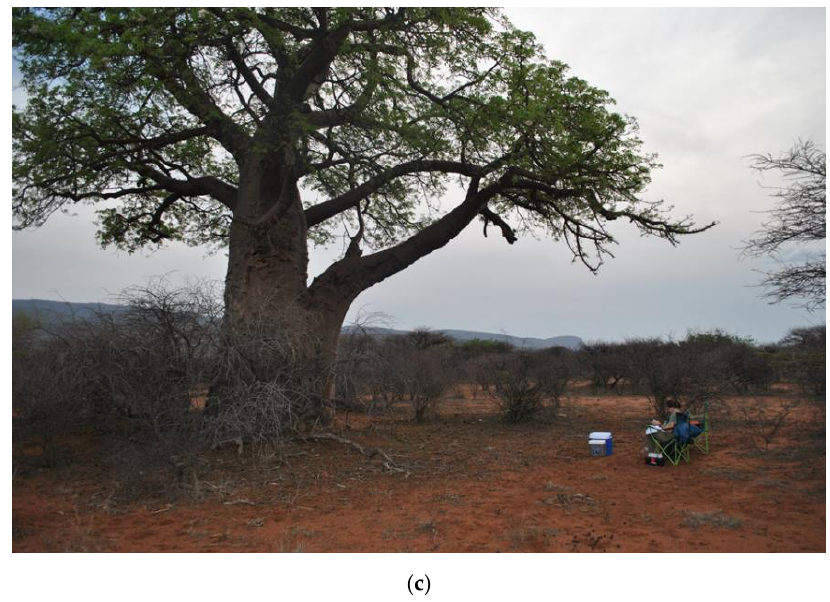
Figure 2. Photographs of ( a ) insect (scarab beetle), ( b ) hawkmoth ( Nephele comma ) visitors to baobab flower and ( c ) researchers preparing for a night of observations during the Baobab Blitz of 2016.